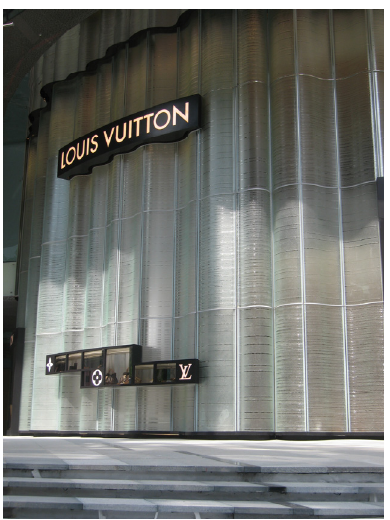
Figure 24a, b: Completed Façade Exterior, Exterior Detail.